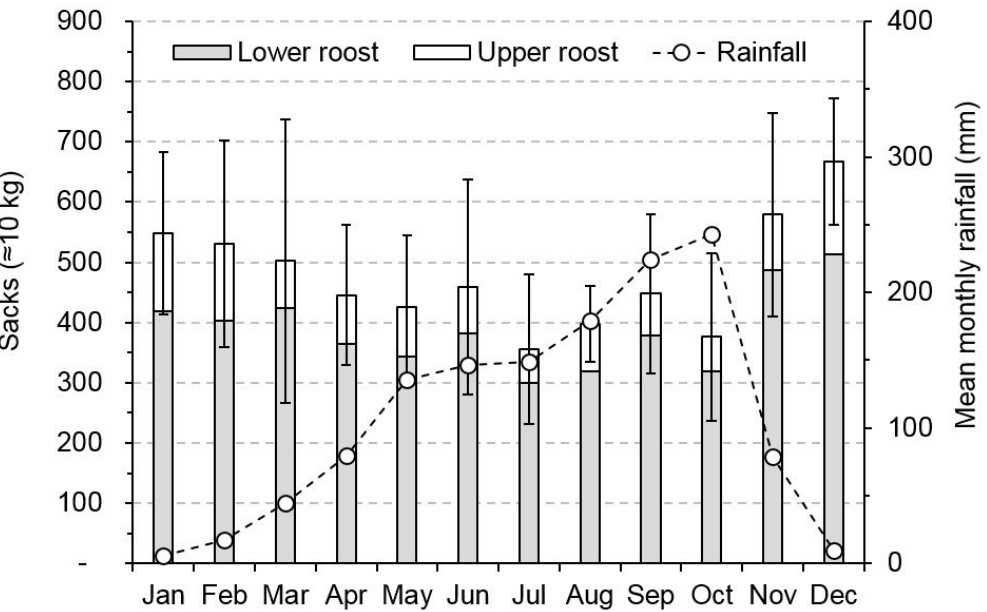
Figure 6. Mean monthly guano harvests from Ta Rumm #1 cave (Battambang province, north-western Cambodia) for January 2011–February 2017 in relation to mean monthly rainfall (1982–2013). Bars represent means and whiskers represent standard deviations.